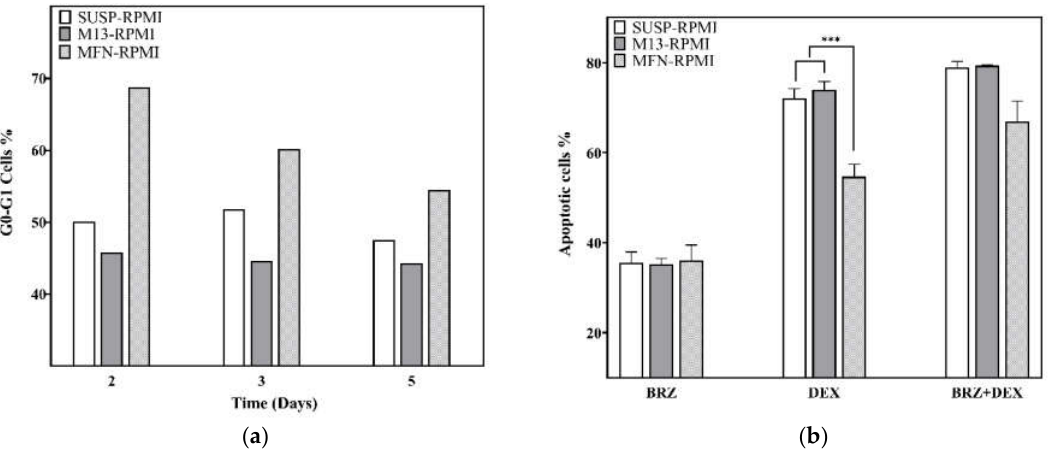
Figure 3. ( a ) Proportion of cells in the G0/G1 phase. ( b ) Results of drug resistance and the synergistic activity effect of both drugs on the RPMI8226 cell line viability. SUSP: suspension culture without microspheres. M13: suspension culture with 13.8% v / v of microspheres with uncoated microspheres. MFN: suspension culture with 13.8% v / v of microspheres coated with fibronectin. Graphic depicts mean ± standard deviation. Level of statistical significance: (***) p -value ≤ 0.001.